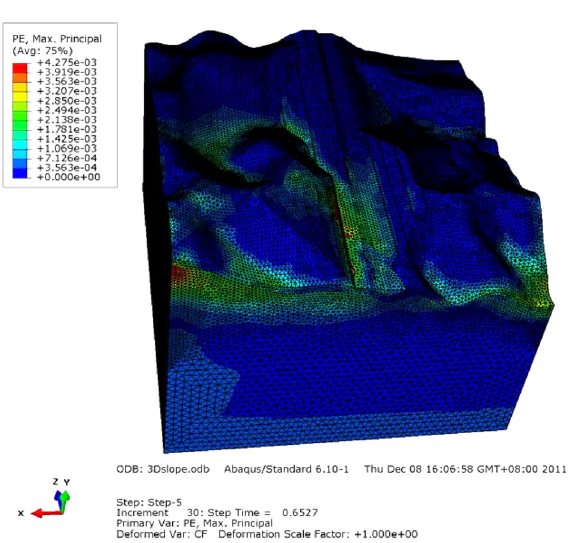
Figure 14. Contour of equivalent plastic strain under